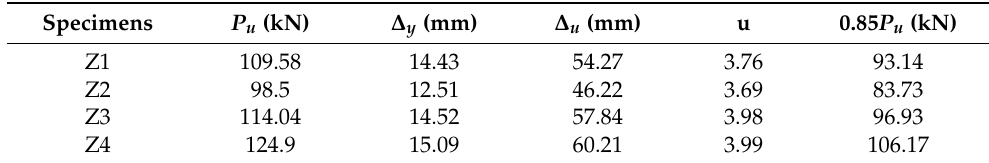
Table 5. Characteristic loads and ductility of specimens.